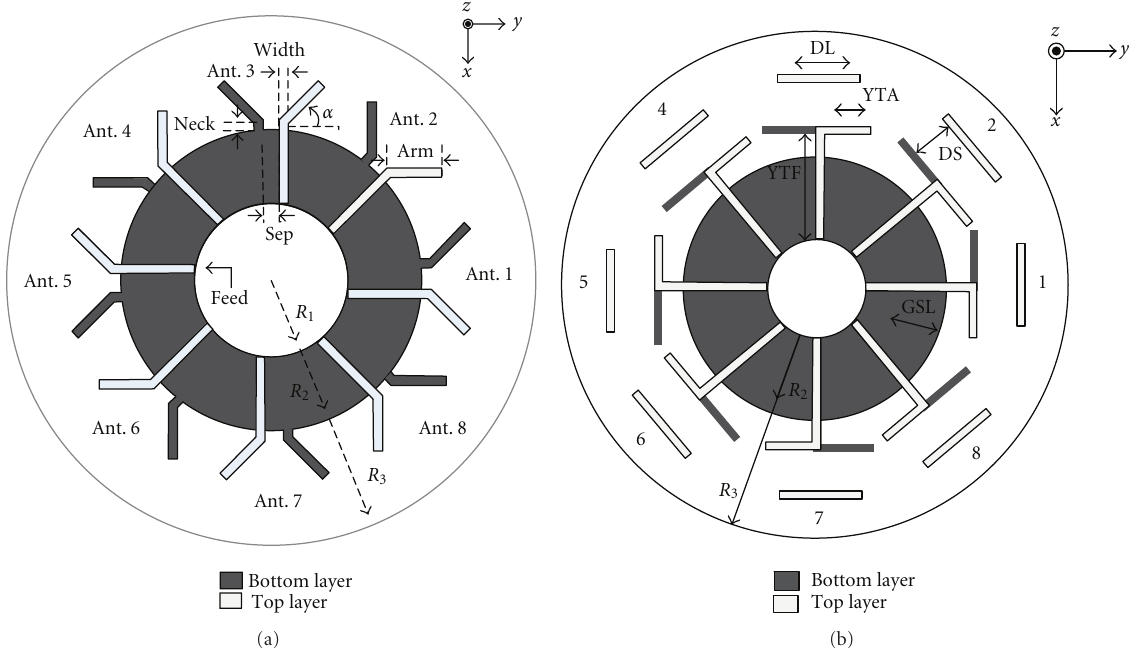
Figure 2: Designs for the printed arrays (a) 8-element V-shaped circular array and (b) 8-element Yagi circular